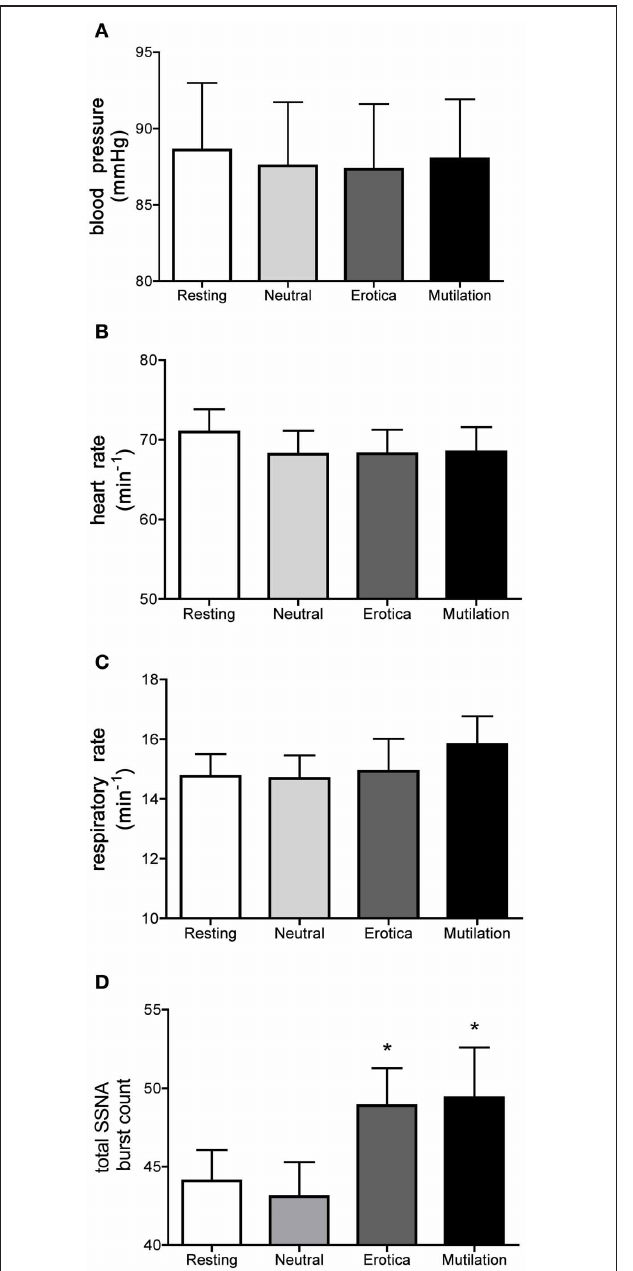
FIGURE 3 | Mean ± SE relative changes in skin blood flow (A), sweat release (B), burst amplitude (C) and frequency of skin sympathetic nerve activity (D), for the resting period, positive images, and negative images, all normalized to the neutral condition. Statistical differences are only seen for SSNA burst amplitude (mutilation) and SSNA burst count (erotica and mutilation). The dashed line represents the neutral value. Statistics refer to differences from neutral. ∗ P < 0 . 05, ∗∗ p < 0 .